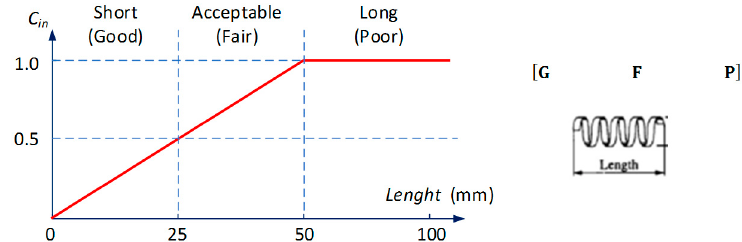
Figure 2. Simplified classification of chip geometry (due to the length of chip ( Lch )).